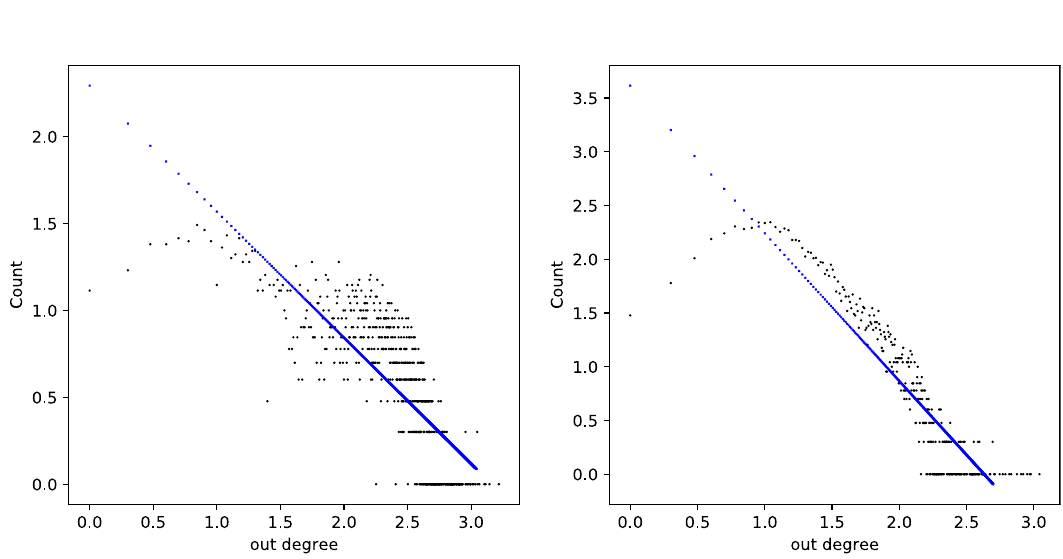
Figure 3: Out - degree distributions for 2008 ( left ) and 2019 ( right )